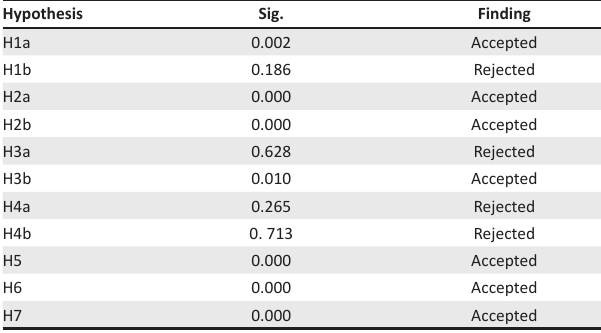
TABLE 11: Hypothesis